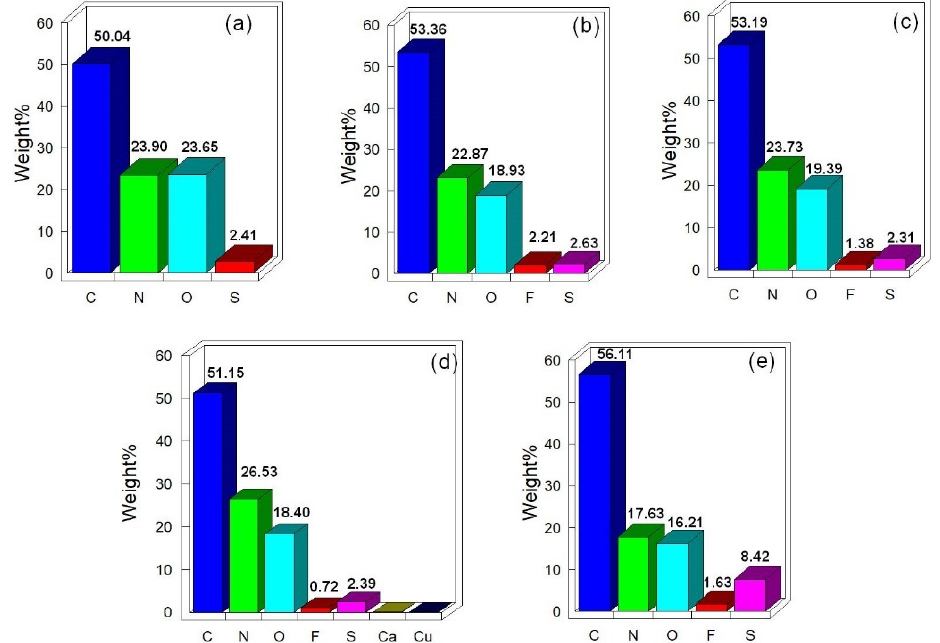
Figure 6. Relative wt. percentage of atoms in different scoured wool samples as characterised by EDX: ( a ) untreated, ( b ) 80 W 6 m 50 sccm, ( c ) 80 W 20 m 50 sccm, ( d ) 150 W 6 m 12 sccm, and ( e ) 150 W 20 m 12 sccm.